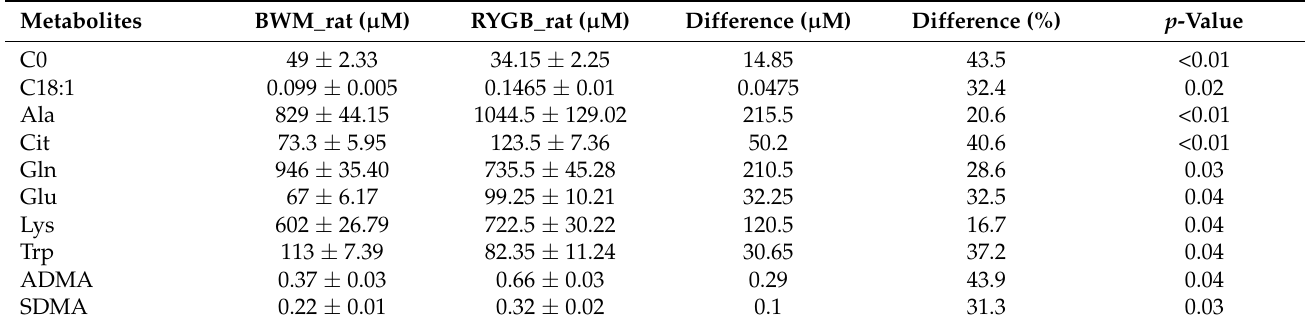
Figure 2. Heat map showing the scaled relative abundance of metabolites, which were significantly different between LS and OP group at one-year follow-up, visualized by hierarchical clustering. Abundance values represent row-wise z-scores of read counts. Each bar in the horizontal columns (which represent different patients) represents the expression intensity. Blue indicates a decreased level, red indicates an increased level. C, acylcarnitine; lysoPC, lysophosphatidylcholine; PC aa, phosphatidylcholine with ester bonding; PC ae phosphatidylcholine with ether bonding; SM, sphingolipid. Table 3. Means of 62 significantly different metabolites at four weeks after start of the interventions between BWM_rat and RYGB_rat with standard deviation. p -values are corrected for multiple comparisons. C, acylcarnitine; lysoPC, lysophosphatidylcholine; PC aa, phosphatidylcholine with ester bonding; PC ae phosphatidylcholine with ether bonding; SM,